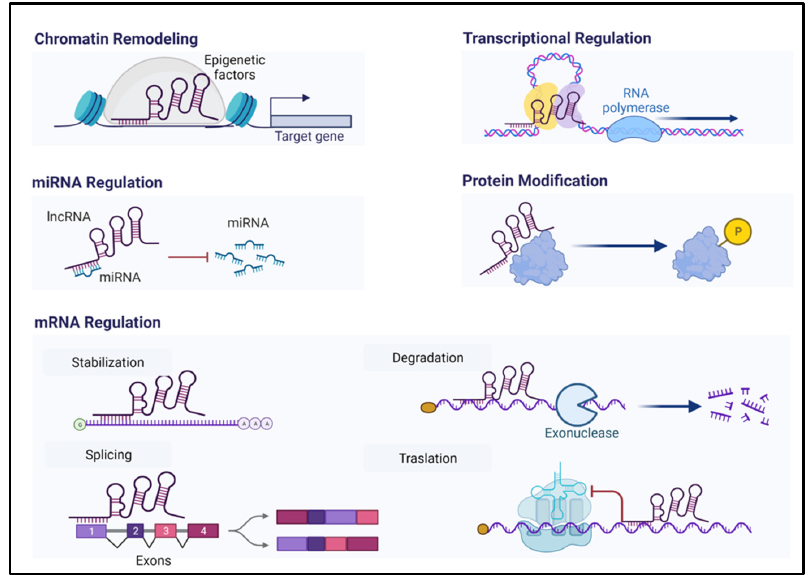
Figure 2. The types of epigenetic regulation exerted by lncRNAs (created with Biorender).